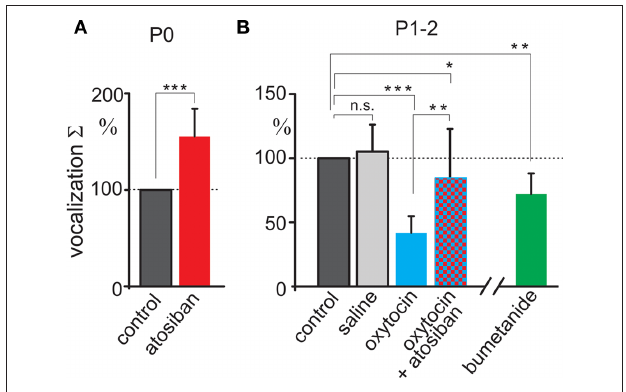
FiGure 3 | Summary plot of the oxytocin modulation of vocalization responses. Scalar vocalization integrals of the responses evoked by electrical whisker pad stimulation in decerebrated rat pups at P0 (A) and at P1–2 (B) . Vocalization integrals are normalized to the control values. Note that vocalizations are enhanced by the oxytocin receptor antagonist atosiban in the newborn rats, and that they are reduced by exogenous oxytocin and NKCC1 blocker bumetanide in P1–2 rat pups. * P < 0.05; ** P < 0.01; *** P < 0.001; n.s., P > 0.05.